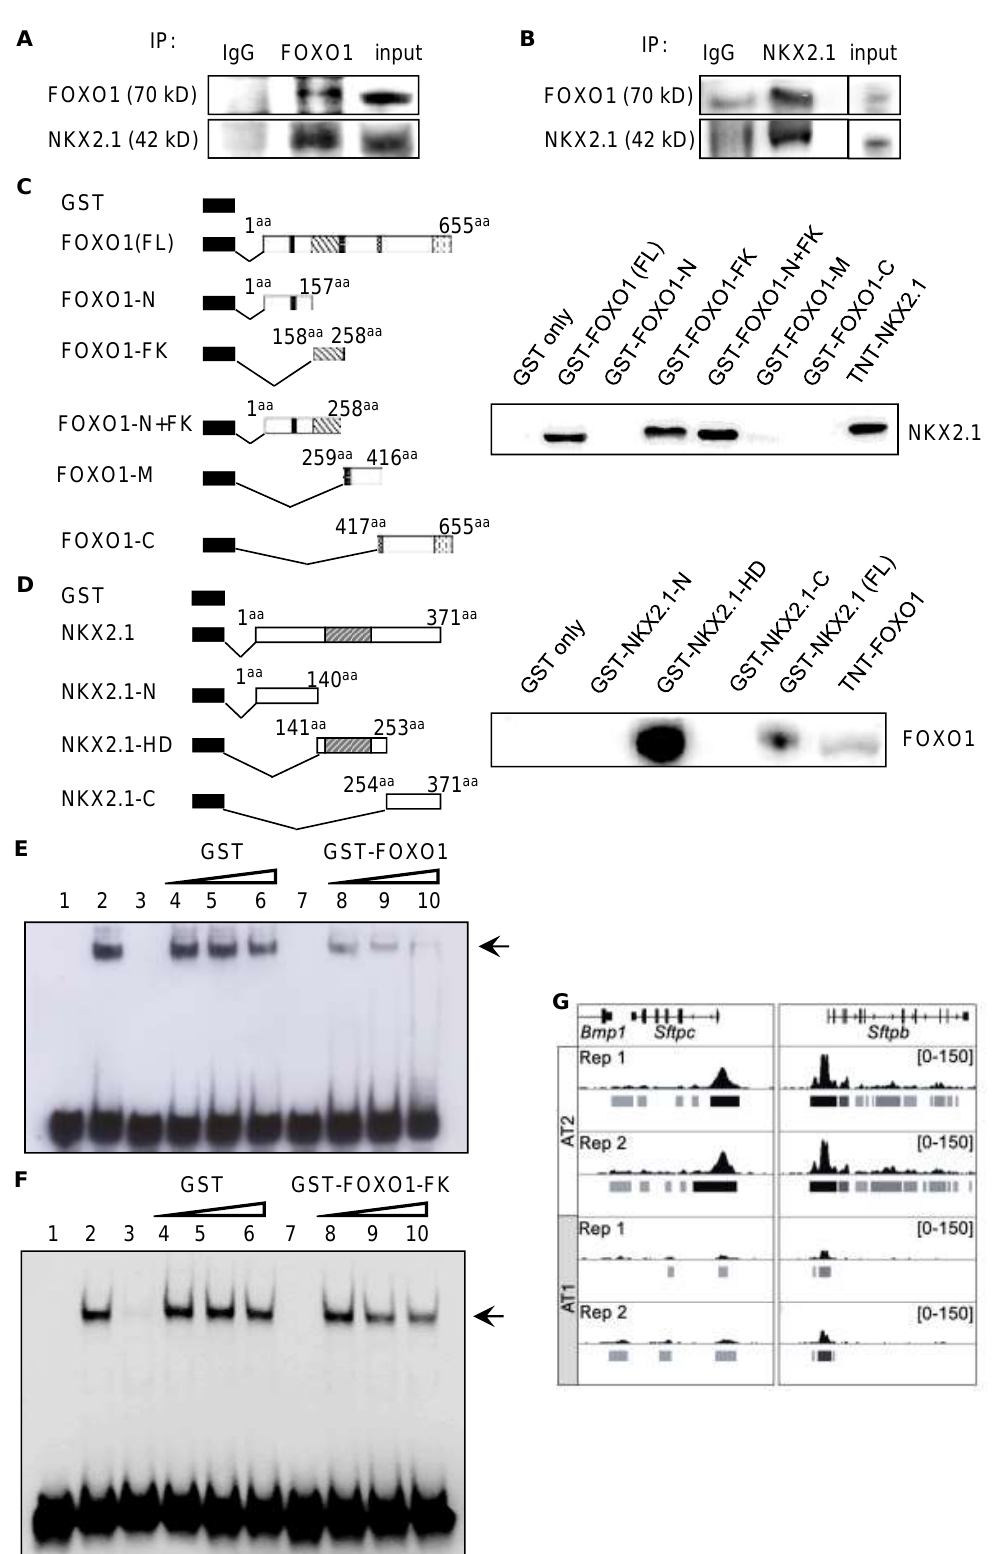
Figure 3. FOXO1 physically interacts with the homeodomain of NKX2.1. Co-immunoprecipitation of nuclear extracts that were harvested from primary AT2 cells on day three in culture with anti-NKX2.1 ( A ) or anti-FOXO1 ( B ) Abs shows the association of endogenous FOXO1 and NKX2.1 ( n = 4). IgG